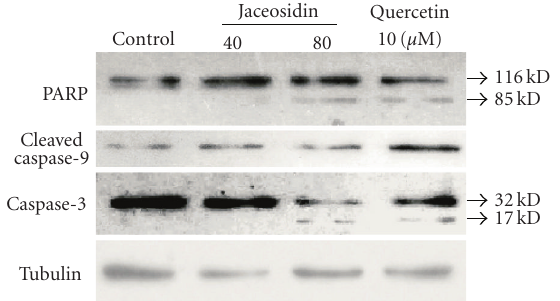
Figure 4: Jaceosidin activates caspase-3 and its related proteins to promote apoptosis. Whole cell lysates prepared from CAOV-3 cells, which had been incubated with jaceosidin or quercetin for 24 hours. The proteins were subjected to Western blot analysis using the respective antibodies as indicated. Data are representative of three separate